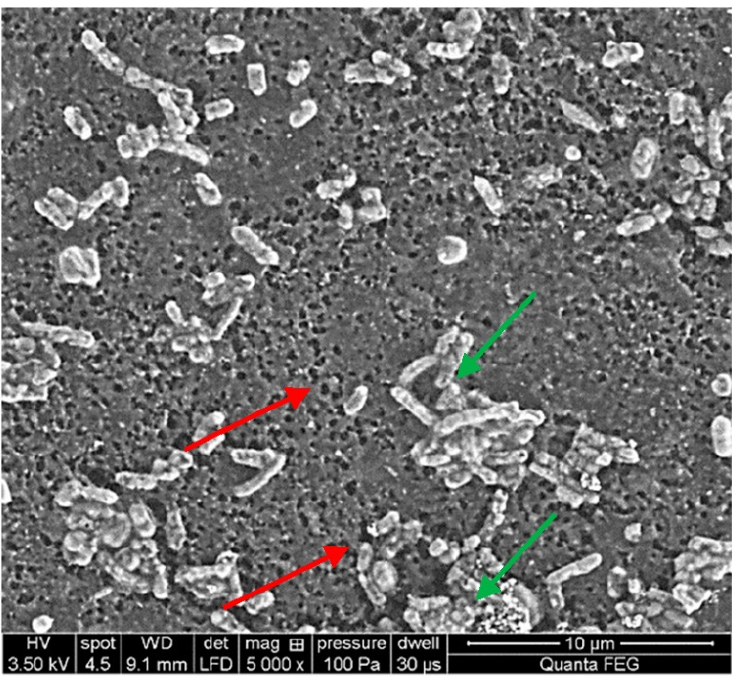
Figure 4. Visible pores in rubber structure (red arrows) and bacteria (green arrows) at the surface of NR + CB + cross-linking substances, after 14 days of cultivation using the Lactobacillus plantarum . In experiments where bacterial activity was observed, mass balances were carried out. The rubber used as the carbon source was weighed before and after experiments. In each case, a mass loss of about 1–5% in relation to the initial weight was observed. The appearance of the rubber material without using a microscope did not change. Under a scanning electron microscope, the presence of pores in rubber structure was observed. The decrease in rubber mass is due to the fact that bacteria, which had grown in the bioreactor, took the carbon necessary for their metabolic processes from it. Statistical analysis (basic descriptive statistics were calculated for the gum mass before and after cultivation (g) and the gum mass loss in (g) and (%) divided into three pH values: 5.6, 5.7, and 5.8) for average weight loss is presented in Table 4. The authors present the results for the most optimal pH values. Table 4. Basic descriptive statistics for mass losses of rubber waste during the 14-day breeding process. pH Variables M Me SD Min. Max.